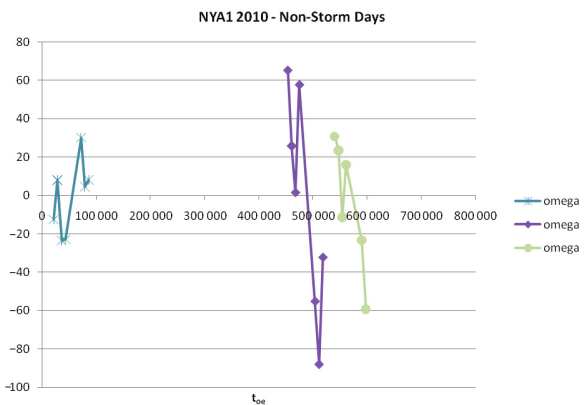
Fig. 20. argument of perigee of three stormless days in 2010 using cPOS stations (NYa1)